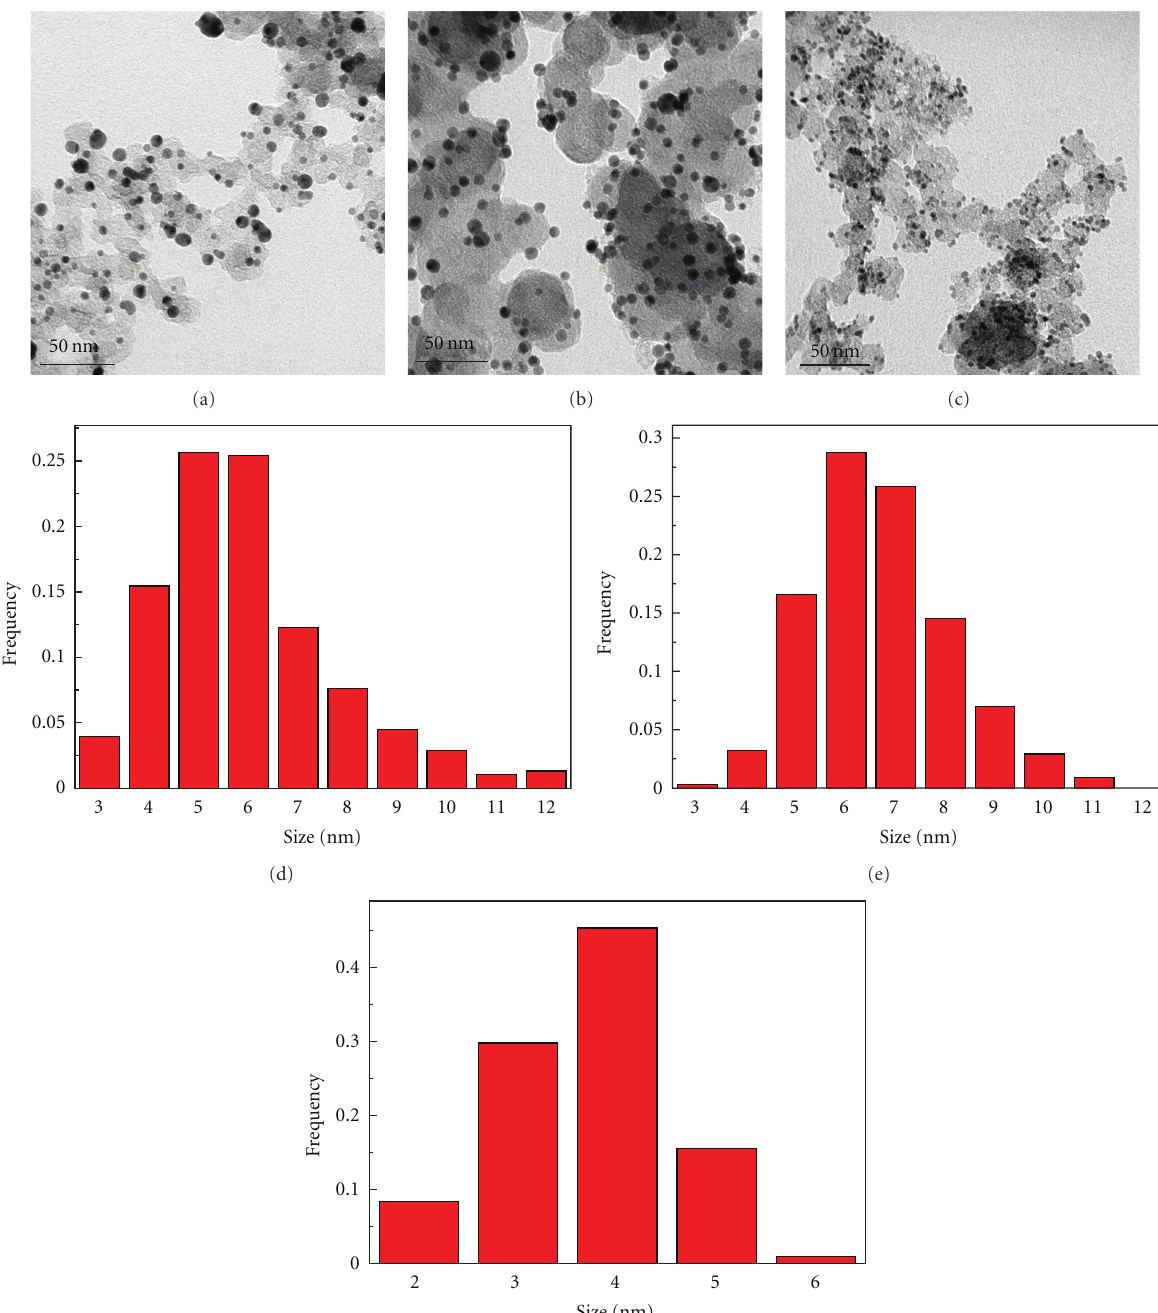
Figure 3: TEM images of Au/C (a), core-shell Au-Pd/C (b), and Pd/C (c) and their corresponding histograms on size